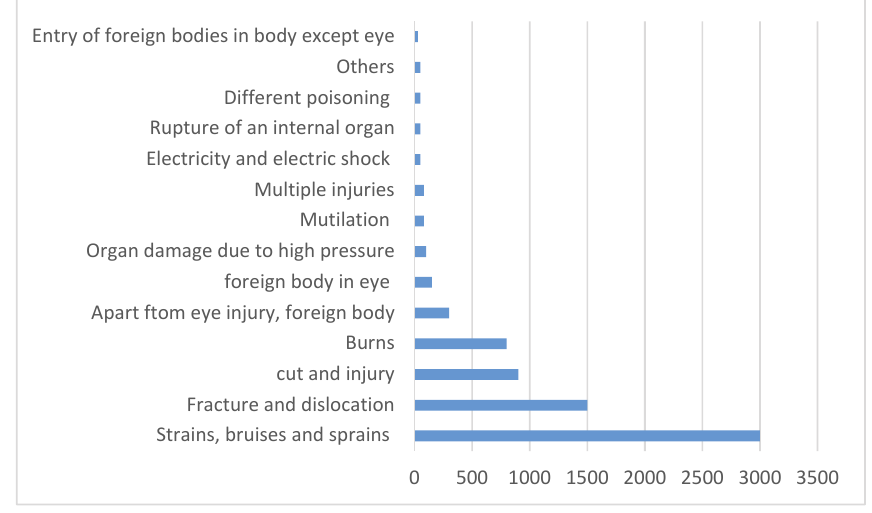
Fig. 1. Distribution of work related accidents in Iran